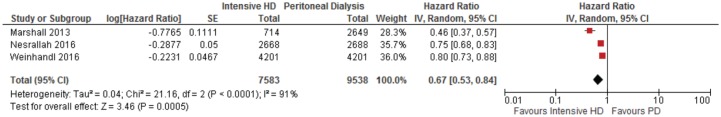
Comparative risk of mortality in intensive HD versus PD.